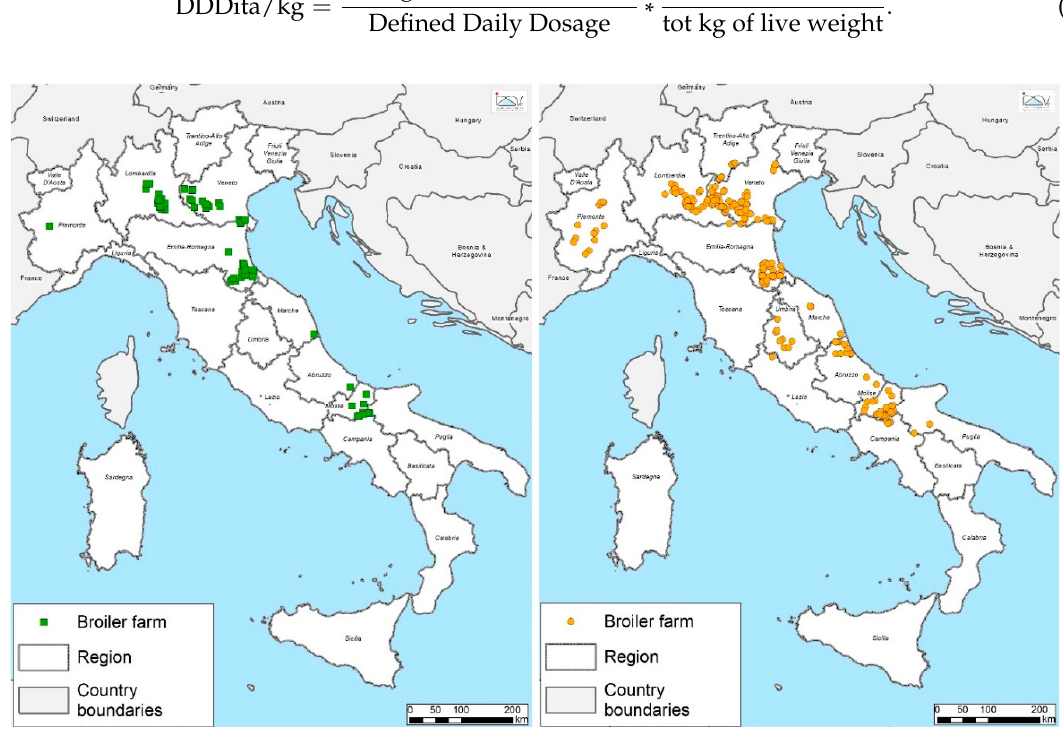
Figure 1. Geographical distribution of the 344 broiler farms enrolled in the study. Green squares indicate farms with the maximum stocking density of 33 kg/m2, and yellow circles indicate farms with a stocking density of 39 kg/m 2 .